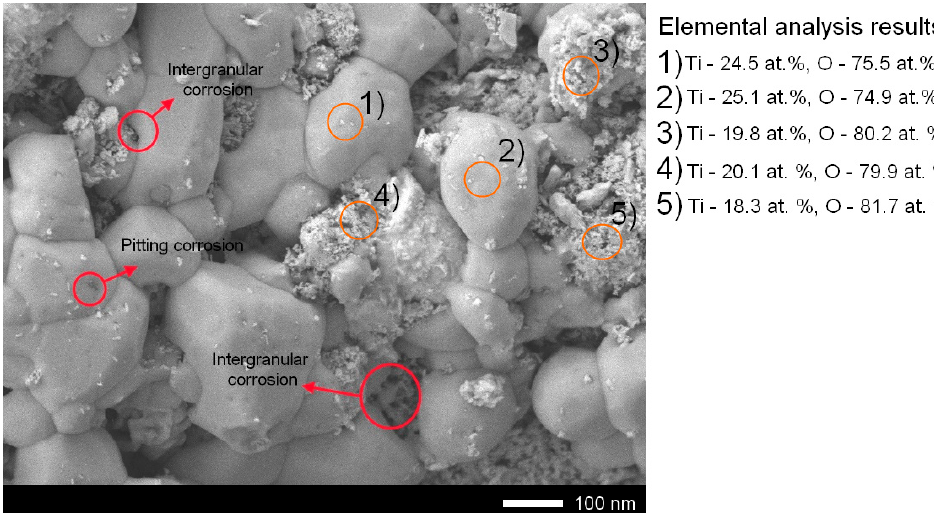
Figure 5. Corrosion results of LTO-3 sample after 30 days of testing.